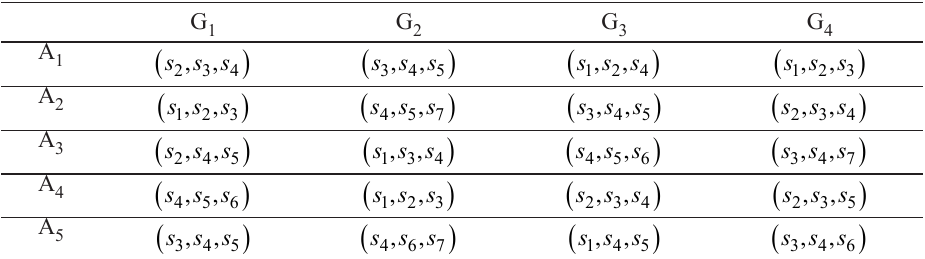
Table 1. Triangular fuzzy linguistic decision matrix